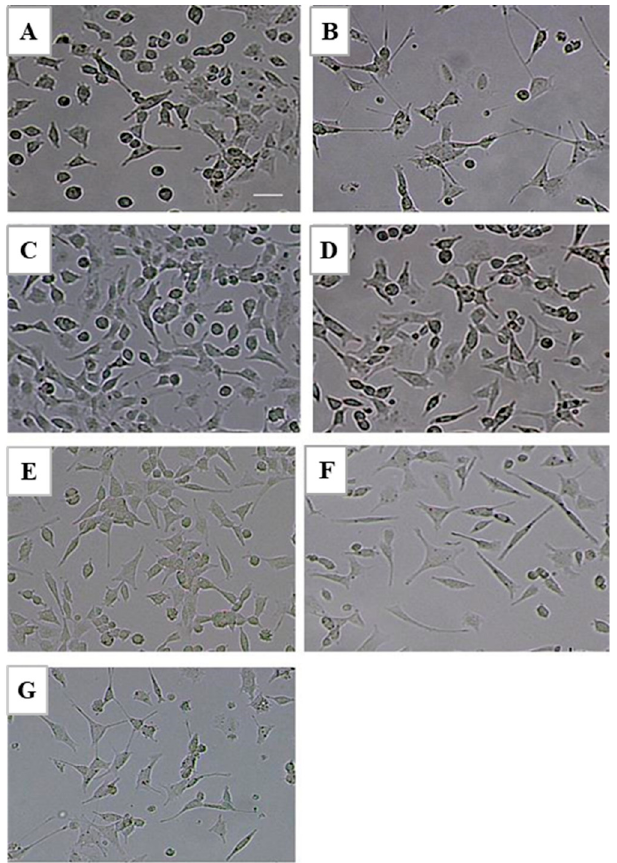
Figure 3. A gradient concentration of LTC-1 promotes the differentiation of PC12 cells. ( A ) Blank control group; ( B ) 30 ng/mL NGF group; ( C – G ) gradient concentration of LTC-1 groups: ( C ) 10 µ g/mL; ( D ) 20 µ g/mL; ( E ) 30 µ g/mL; ( F ) 40 µ g/mL; ( G ) 50 µ g/mL.